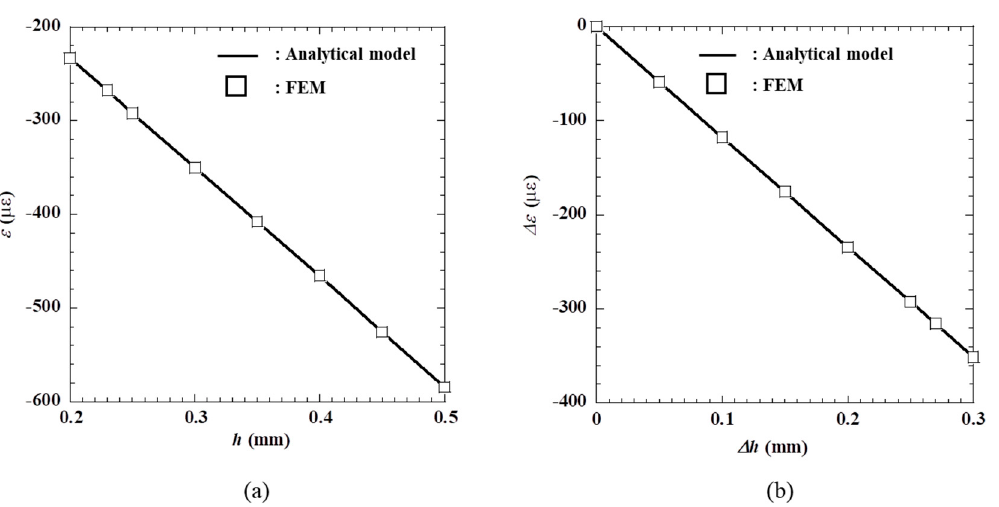
Figure 7. The side view of xy plane of FEM-simulated strain distribution on the back side of the test piece with and without a reduction in thickness, ( a ) in the axial direction, and ( b ) in the transverse direction.